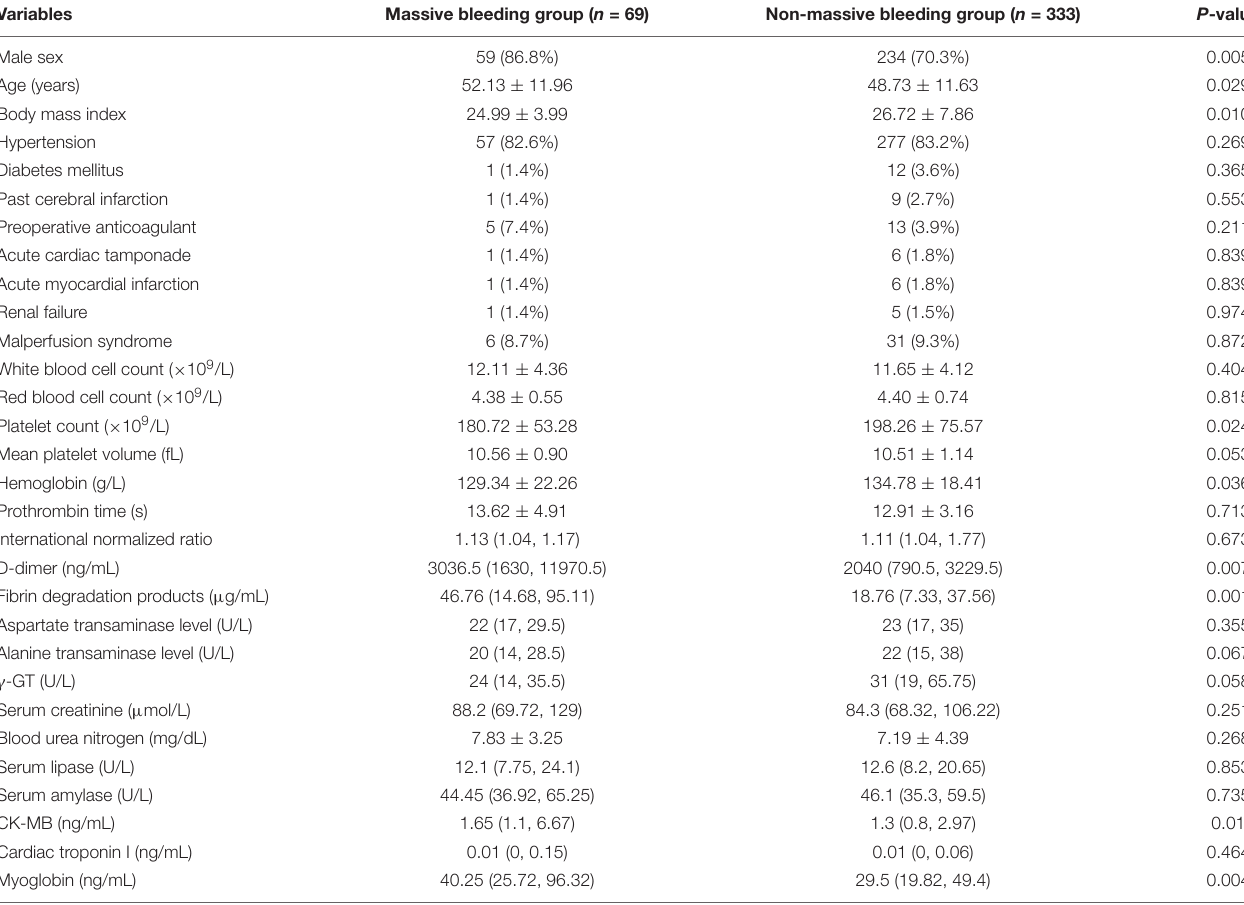
TABLE 1 | Preoperative characteristics of the study population.